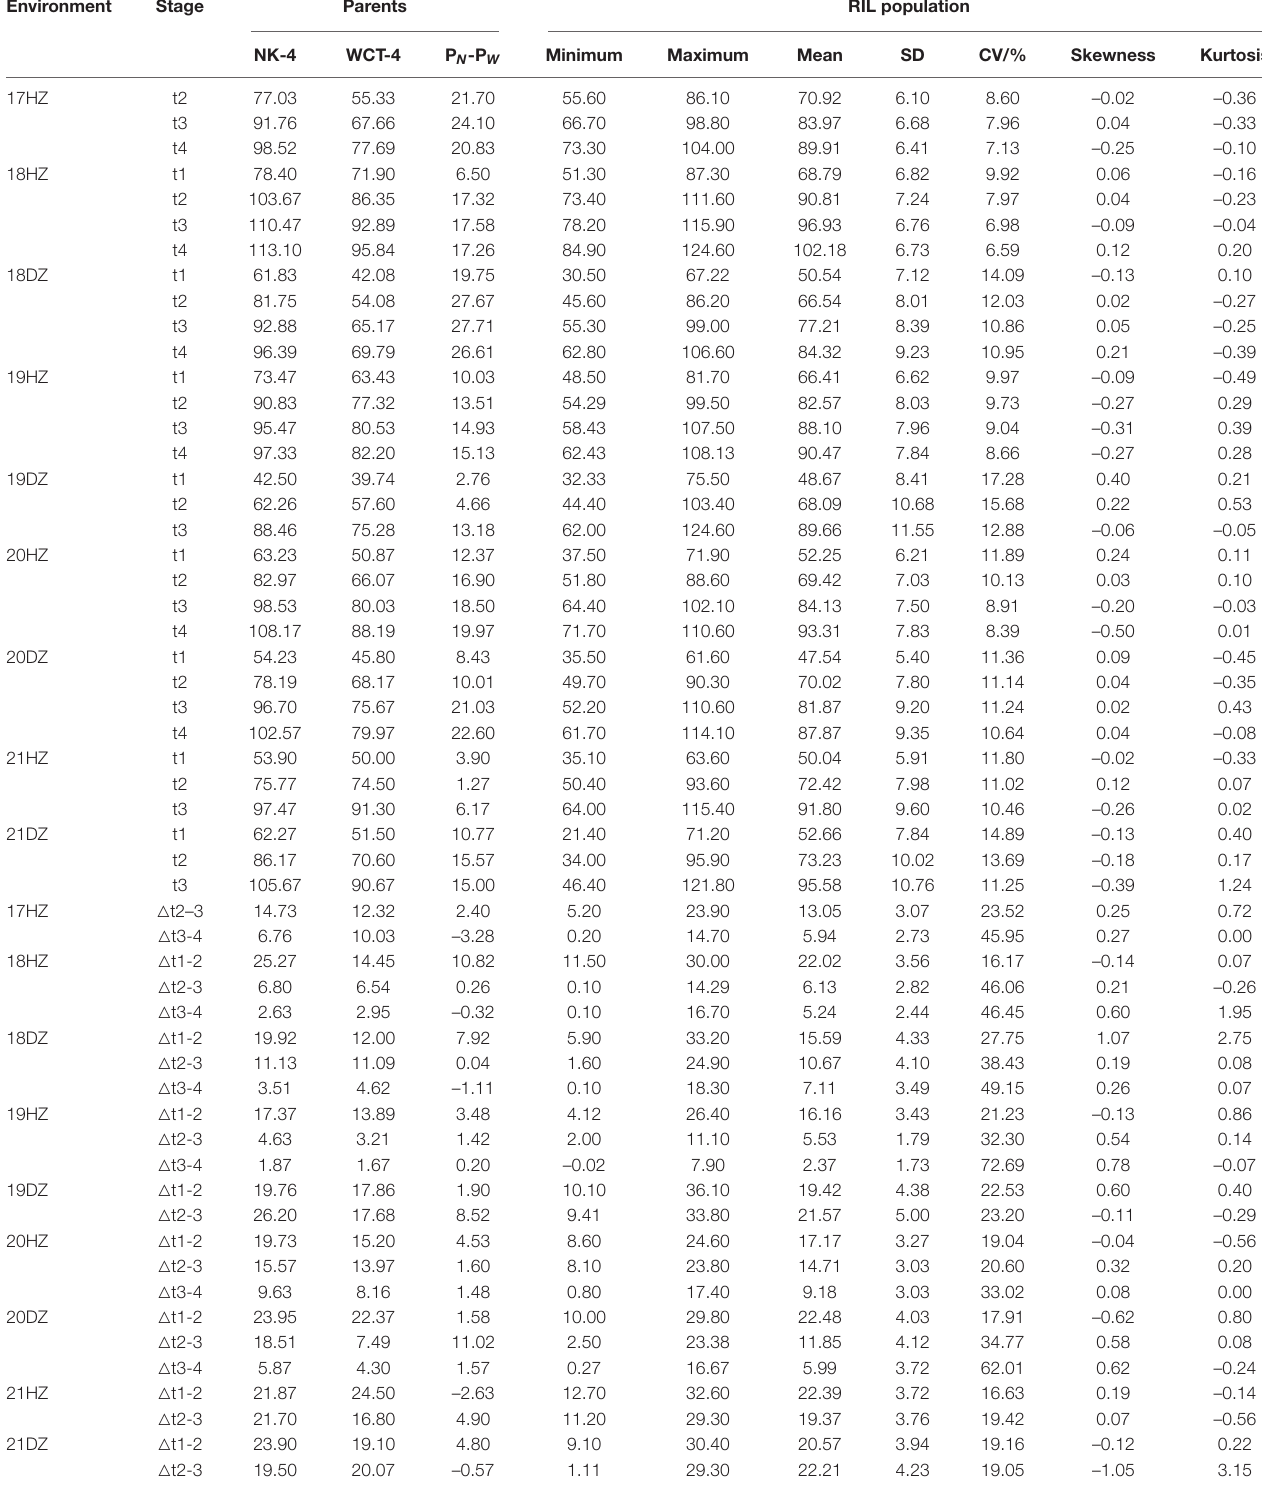
TABLE 1 | Plant height performance of recombinant inbred lines (RILs) and their parents. Environment